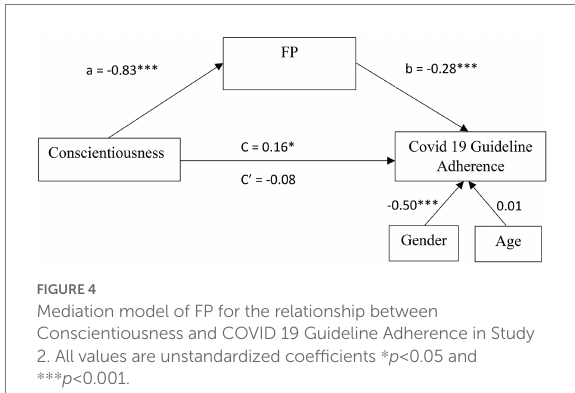
FIGURE 4 Mediation model of FP for the relationship between Conscientiousness and COVID 19 Guideline Adherence in Study 2. All values are unstandardized coefficients * p < 0.05 and *** p <